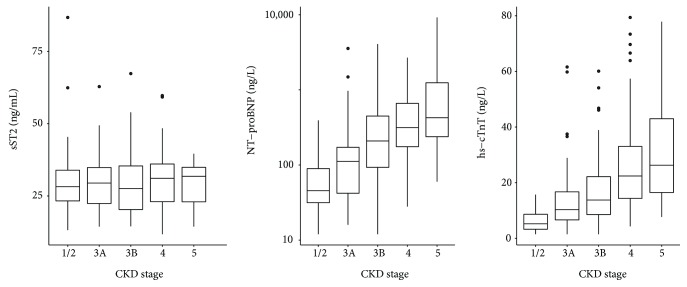
sST2, NT-proBNP, and hs-cTnT levels according to CKD stages (Kruskal-Wallis test: p = 0.9, p < 0.001, and p < 0.001, respectively).